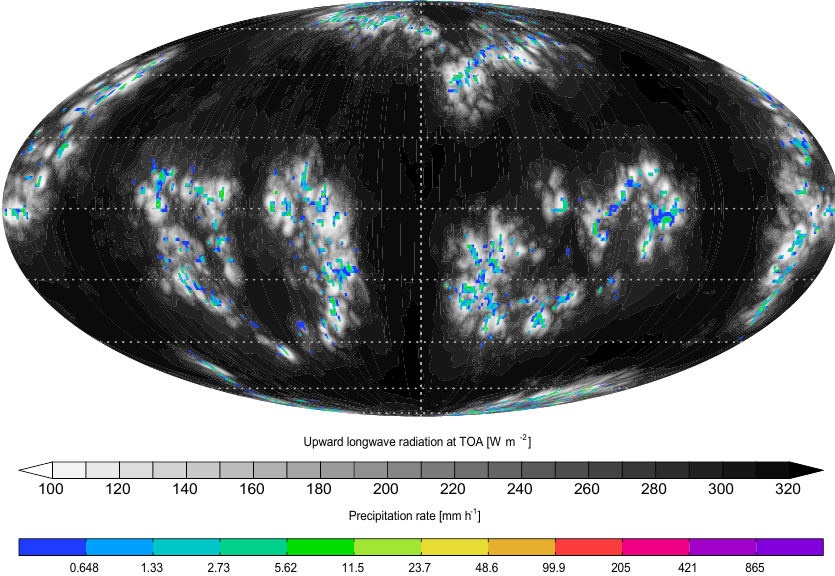
Figure 8. Hourly-averaged OLR at the top of atmosphere (gray shading) and precipitation rate (color shading) in a NICAM simulation at T s = 300K. Note that several parameters do not precisely follow the RCEMIP